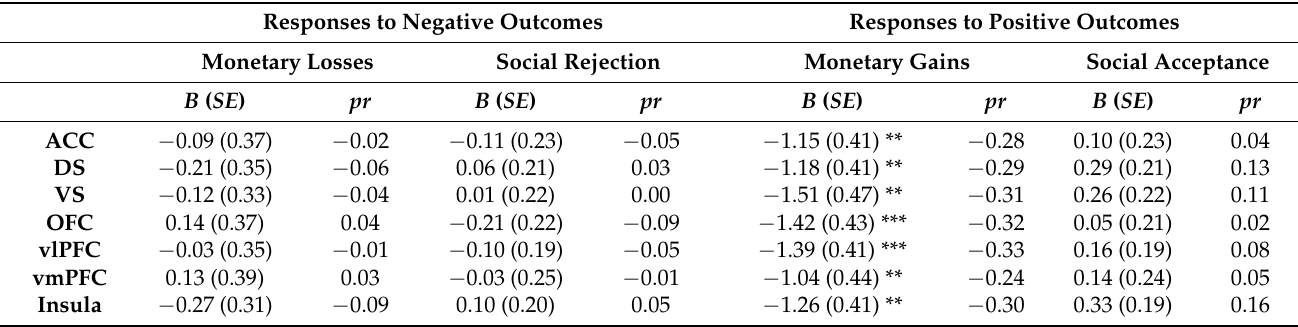
Table 2. Associations between NSSI status and neural responses to negative and positive outcomes in a priori ROIs. Responses to Negative